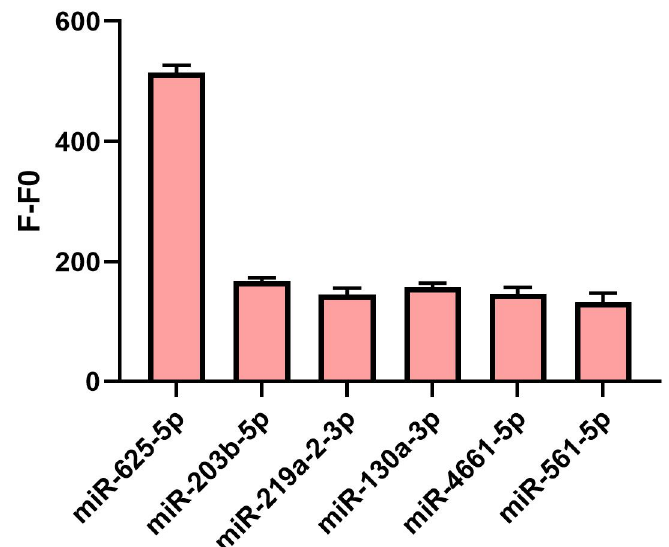
Figure 7. The specificity assay of miR-625-5p. The concentration of miR-625-5p and other interfering miRNAs were 100 nM. All data are presented as mean ± SD. Each assay was performed in triplicate.